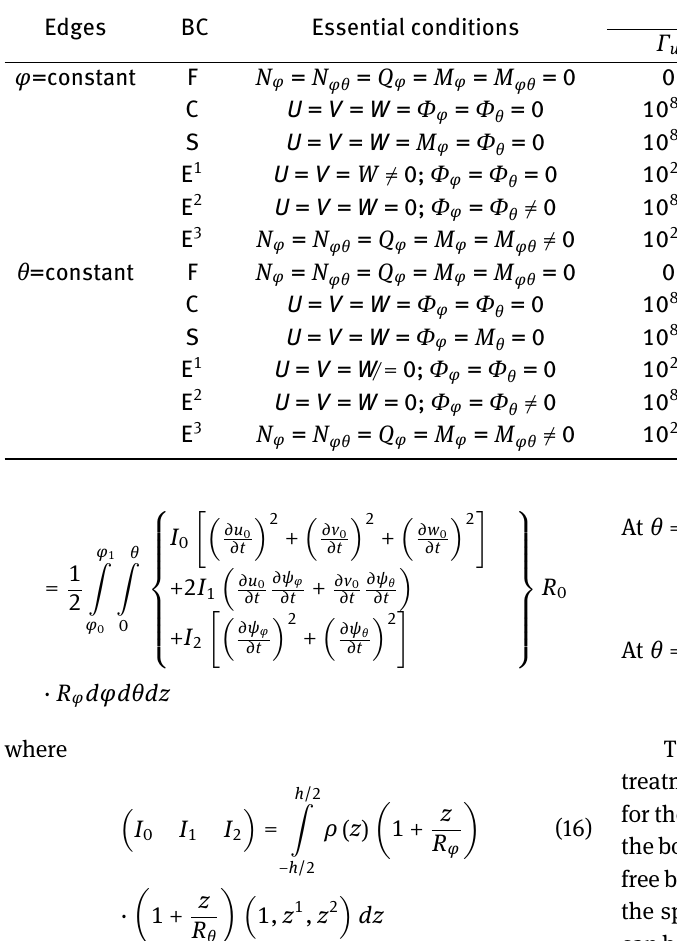
Corresponding spring stiffness